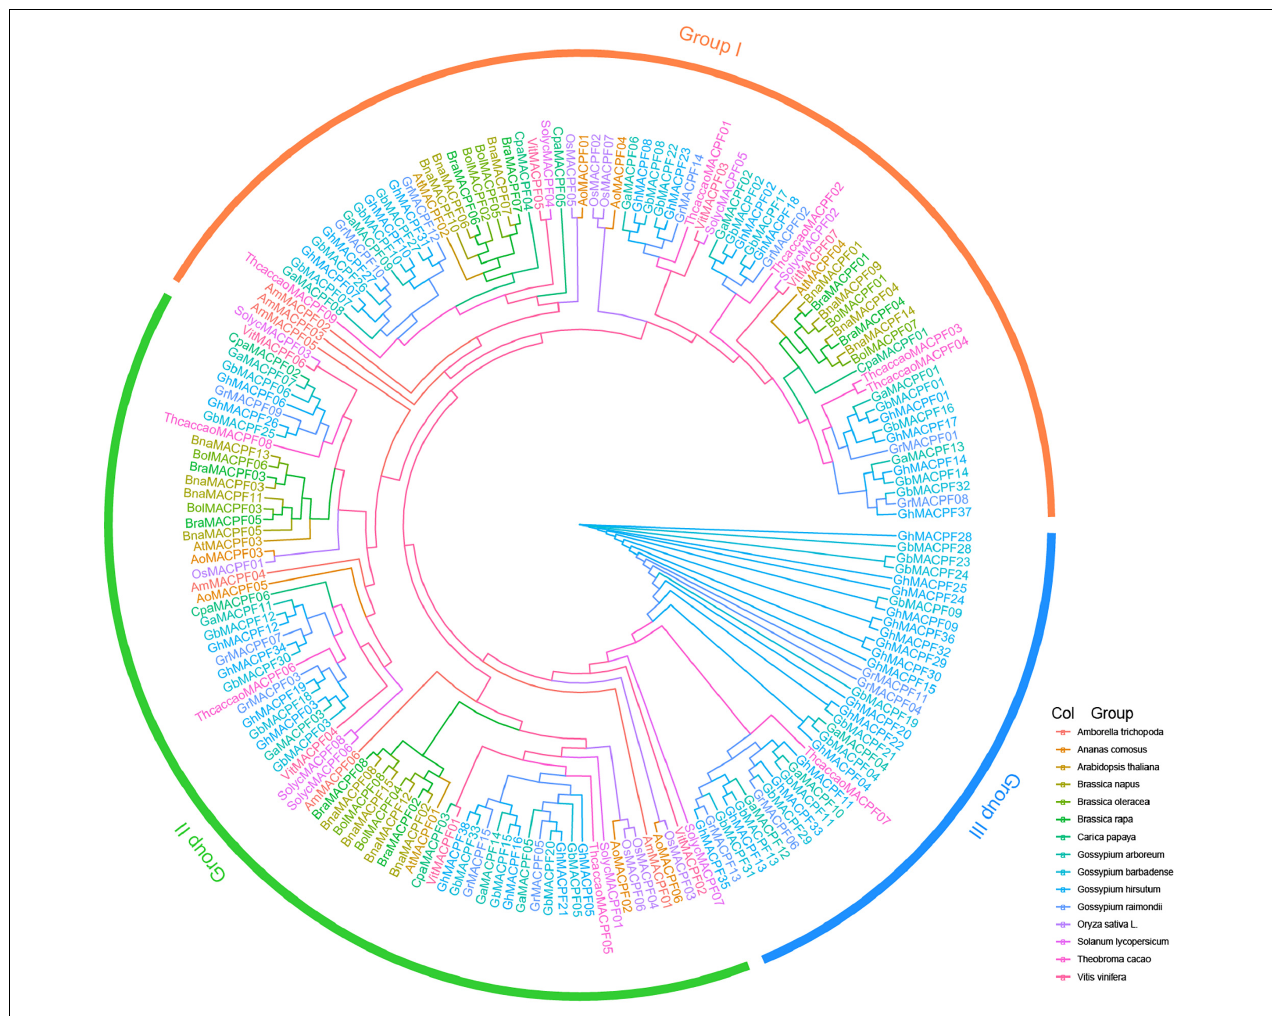
FIGURE 1 | A phylogenetic tree of the membrane attack complex/perforin ( MACPF ) gene family. All the sequences of the MACPF domain gene in four Gossypium spp. and 11 other plants were carried out by using the maximum likelihood (ML) method in PhyML and members in the same species belong to the same